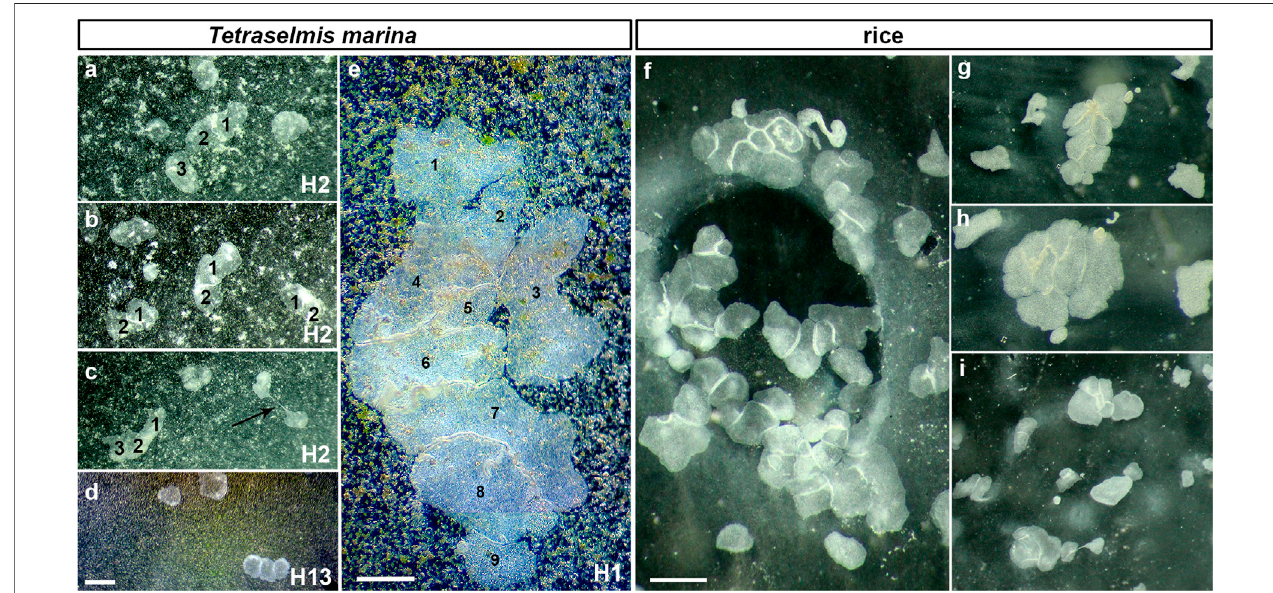
FIGURE 2 | Social feeding behavior during long-term culturing on the dense algal ( Tetraselmis marina box) and rice (for H1-f) substrates (illustrated examples). The aggregationofanimalsdependeduponthedensityofthesubstrates(seemode#3inthetextand Figure3 ).Thisbehavioralpatternwasobservedforallhaplotypes(H1, H2, H13 — in Petri dishes). The arrow in c indicates a fi ssion process. Aggregates often included 2 – 15 individuals. For example, there were aggregates of 2-3 animals in H2 (A – C) on Tetraselmis marina , and 9 H1 individuals (E) at the same substrate; but H2 often forms aggregates for 10 – 15 animals around rice grains (G – I) . pH